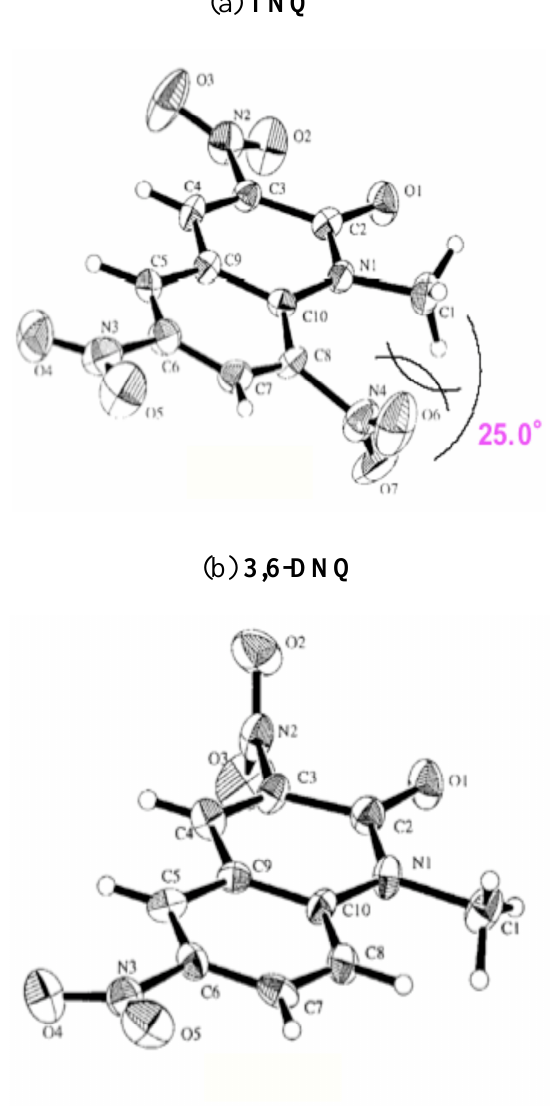
Figure 2. (a) An ORTEP view of TNQ . (b) An ORTEP view of 3,6-DNQ . (30% probability